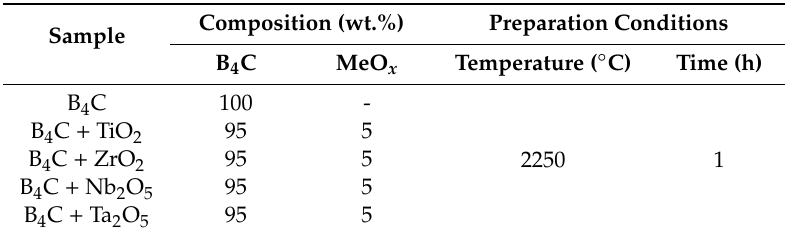
Table 1. The starting compositions (in wt.%) and processing conditions of sintered compounds. Composition Sample